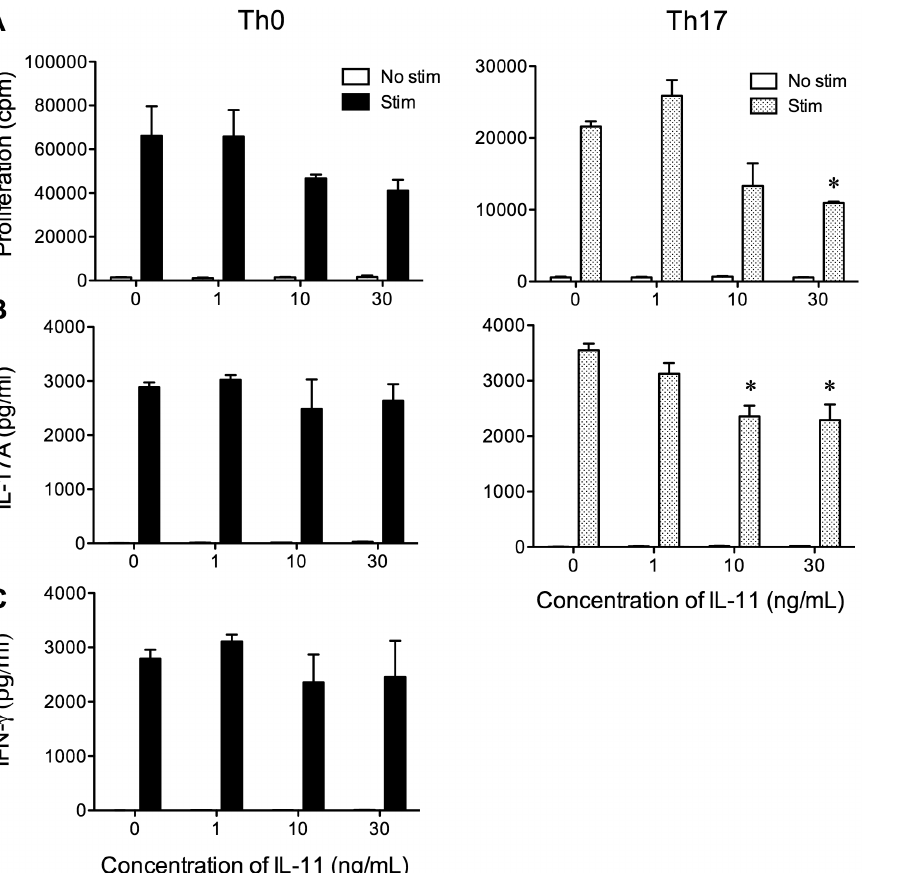
Figure 5. IL-11 inhibits the proliferation and IL-17A production by lymph node cells under Th17-polarizing conditions. Lymph node cells were harvested from C57BL/6J mice (N=3/group). They were dissociated into a single-cell suspension and were stimulated with plate-bound anti-CD3 and anti-CD28 (0.5 m g/ml) in the absence of added cytokines (Th0) or in the presence of IL-6 (30 ng/ml), TGF- b (3 ng/ml) and anti-IFN- c neutralizing antibody (10 m g/ml). The proliferation of ( A ) and IL-17A ( B ) and IFN- c ( C ) cytokine production by lymph node cells was measured using H 3 -thymidine incorporation and ELISA assays, respectively. Values represent mean + SEM pg/ml or cpm in triplicate cultures. Results are representative of two individual experiments. *indicates a significant (p , 0.05) difference from the 0 ng/ml concentration group as determined using a one-way ANOVA and Tukey post-hoc test. Note that IFN- c was not detected under Th17 skewing conditions and is not shown.